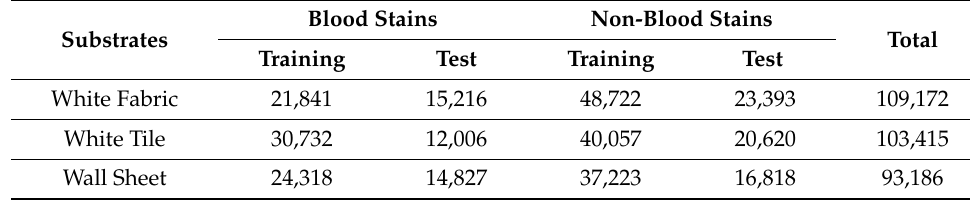
Table 2. Samples-based data splitting.